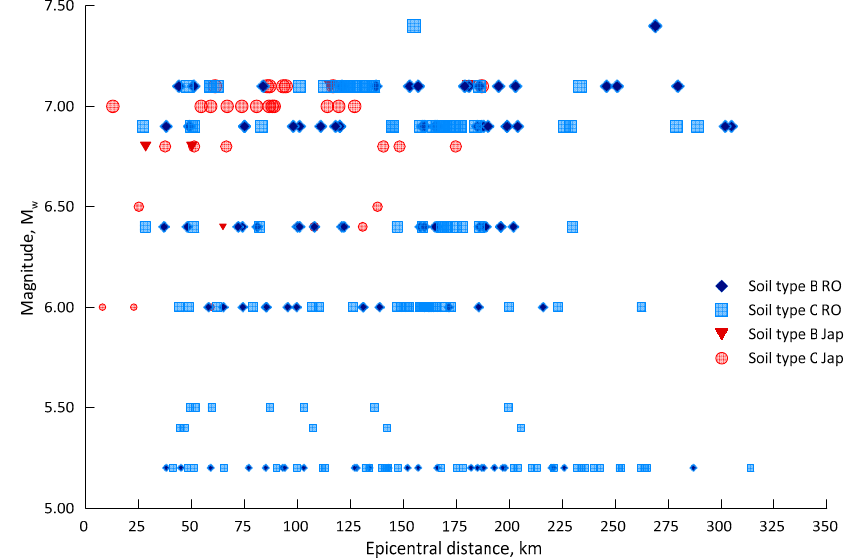
Figure 1. Origin, ground type, magnitude and epicentral distance distribution of the records.